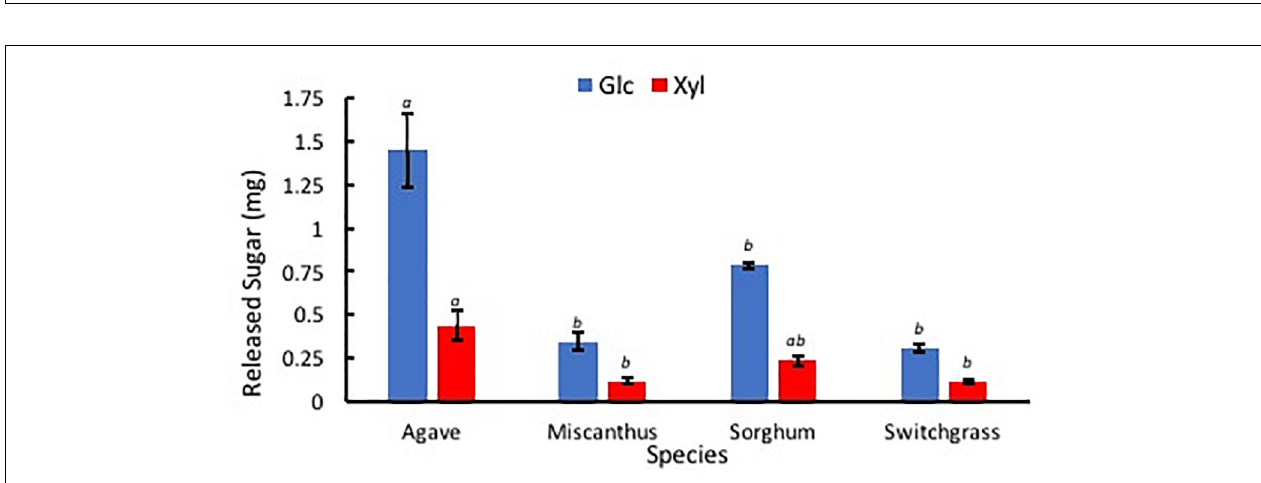
FIGURE 7 | Relationships associated with percentage structural carbohydrates per unit dry biomass (%) and GH for A. americana ( (cid:78) ), Miscanthus ( (cid:4) ), Sorghum ( • ), and switchgrass ( (cid:7) ). Error bars indicate standard error of the mean; n = 3 for GH; n for composition is reported in Supplementary Table 1 .